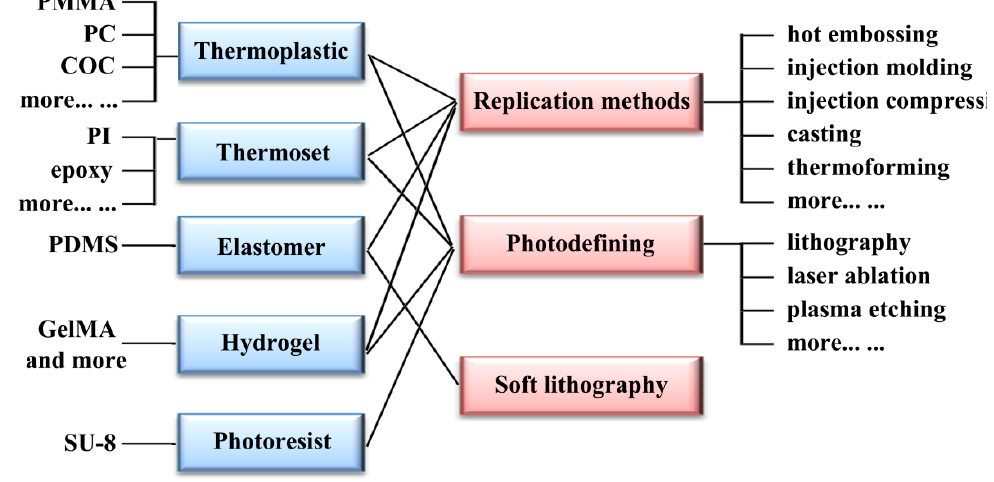
Figure 6. Illustrative schematic of the relationship between different kinds of polymer materials and manufacturing methods for polymer-based microfluidics. manufacturing methods for polymer-based